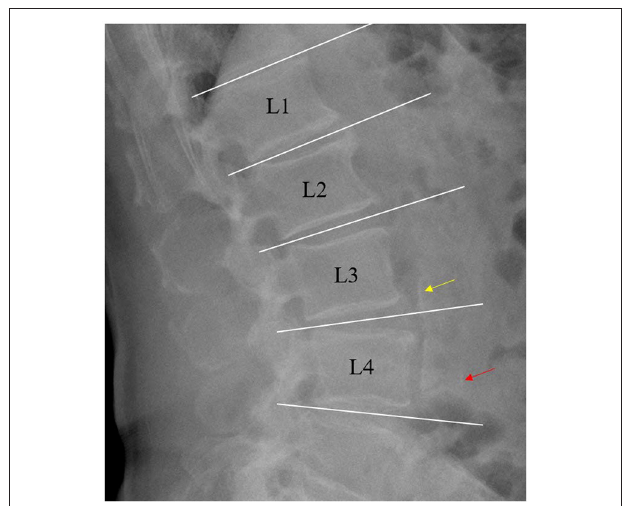
FIGURE 1 | Example of lateral abdomen radiograph showing calcification of the anterior (red arrow) and posterior wall (yellow arrow) of the abdominal aorta.